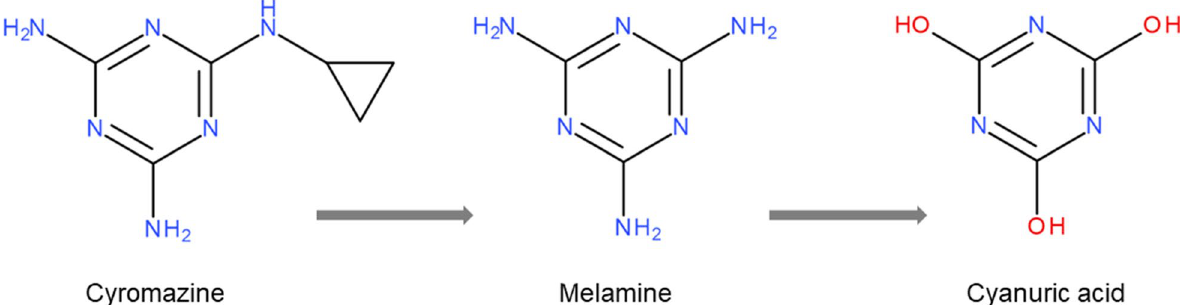
Fig. 1 Degradation pathway of cyromazine via melamine and cyanuric acid (according to